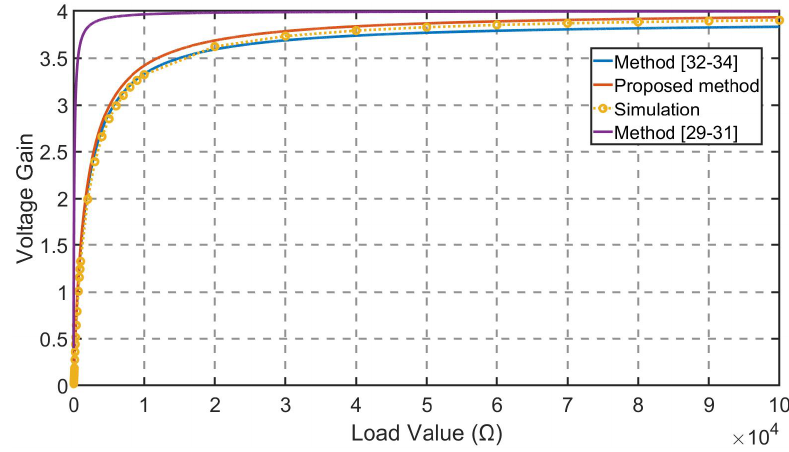
Figure 11. Comparison of calculated voltage gains from proposed and existing methods, as well as simulated ones, at different load